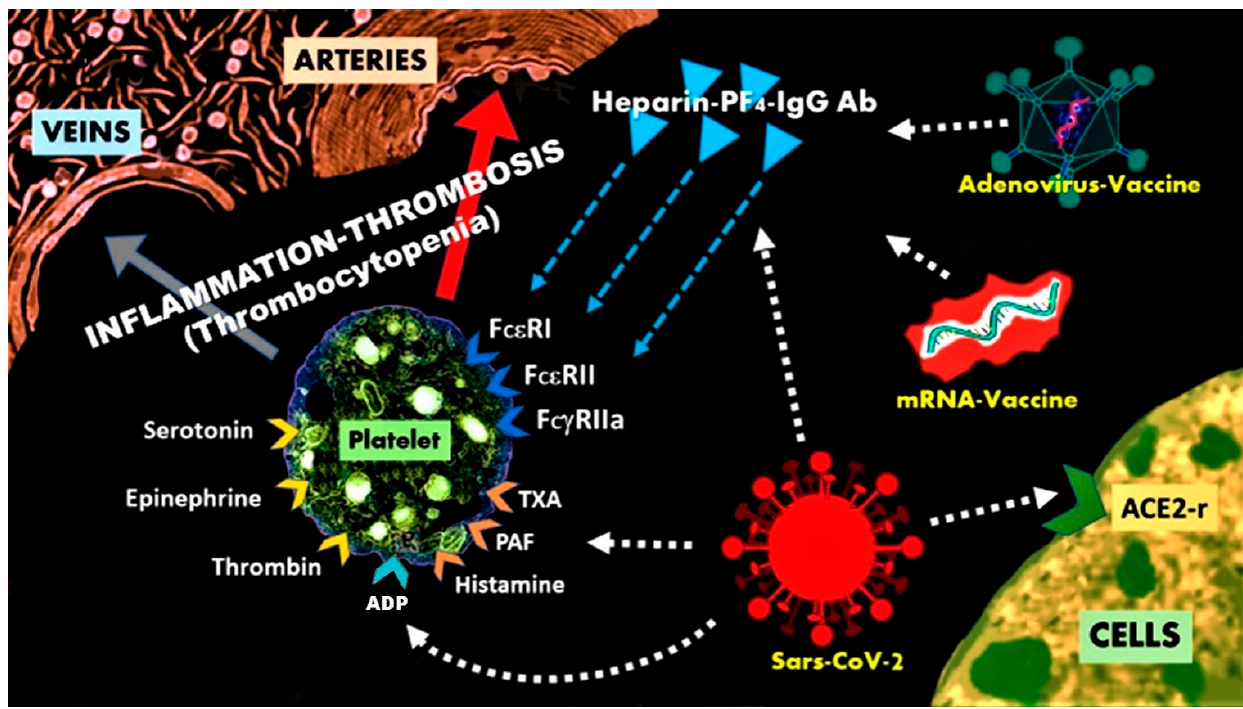
Figure 2. The heparin-PF4-IgG antibody complexes can activate platelets, via the Fc ε RI, Fc ε RII, Fc γ RII receptors and cause heparin-induced thrombocytopenia with thrombosis.